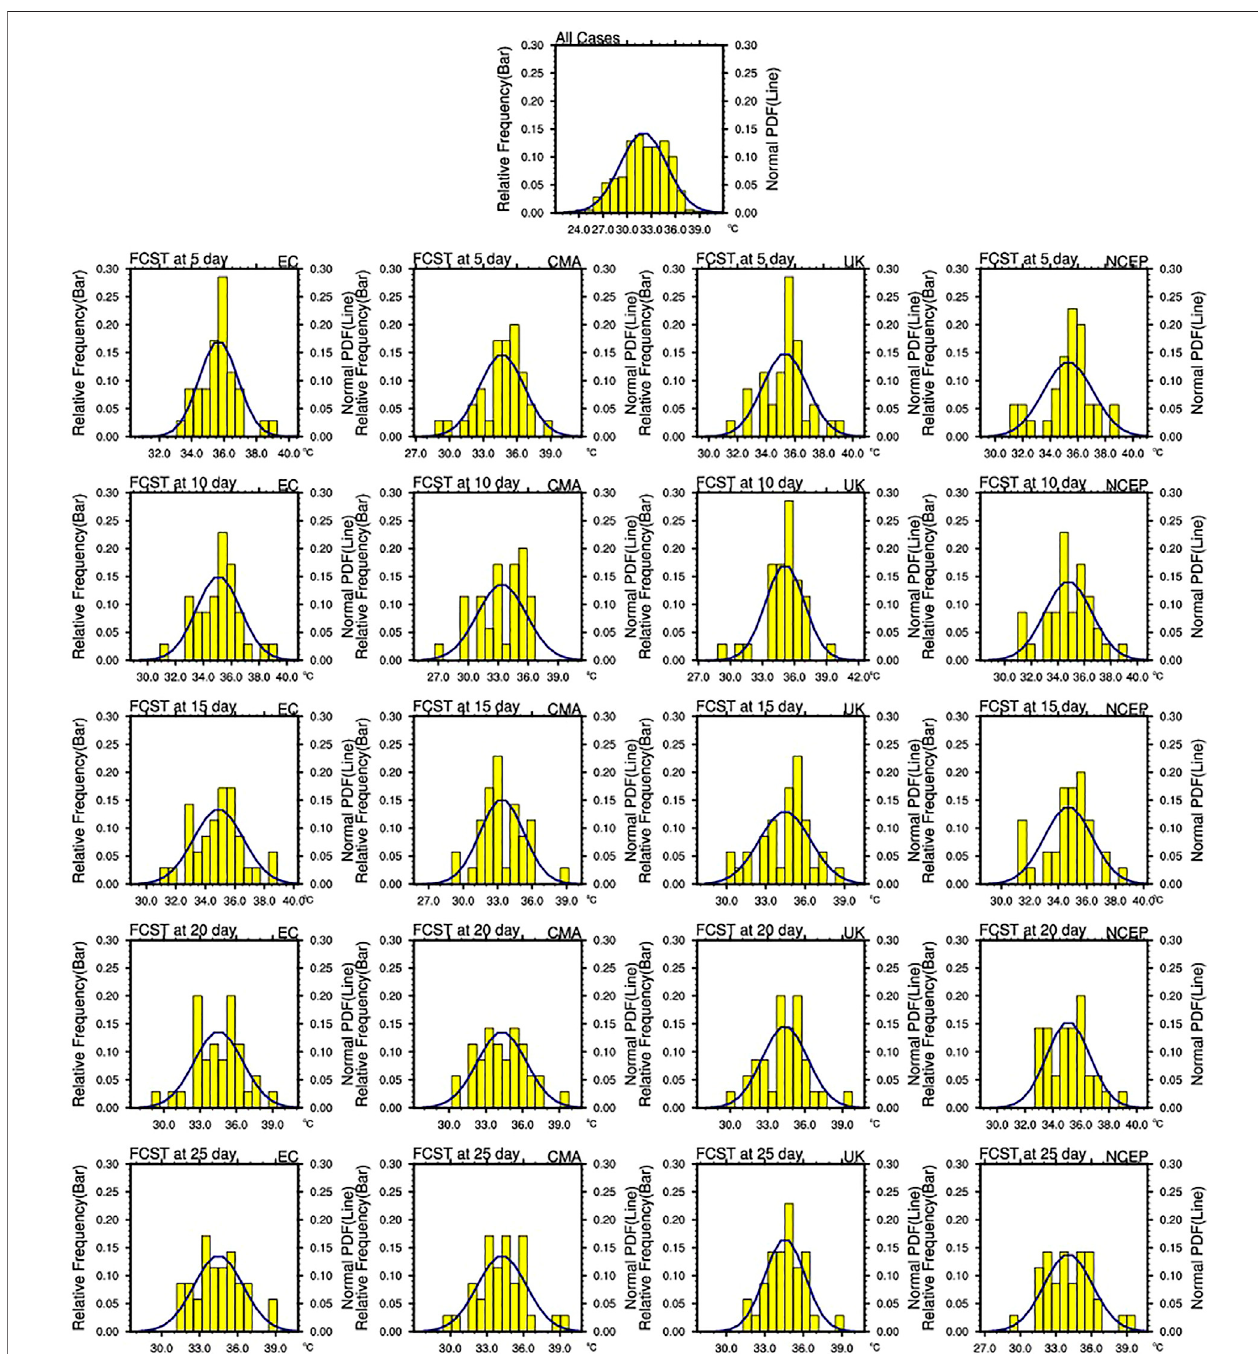
FIGURE 6 | Histograms of observed HWI conditional on the forecasting of heatwaves. The rows from top to bottom correspond to the lead days at 5, 10, 15, 20, 25. The columns from left to right correspond to the different forecast models (ECMWF, CMA, UKMO, NCEP).